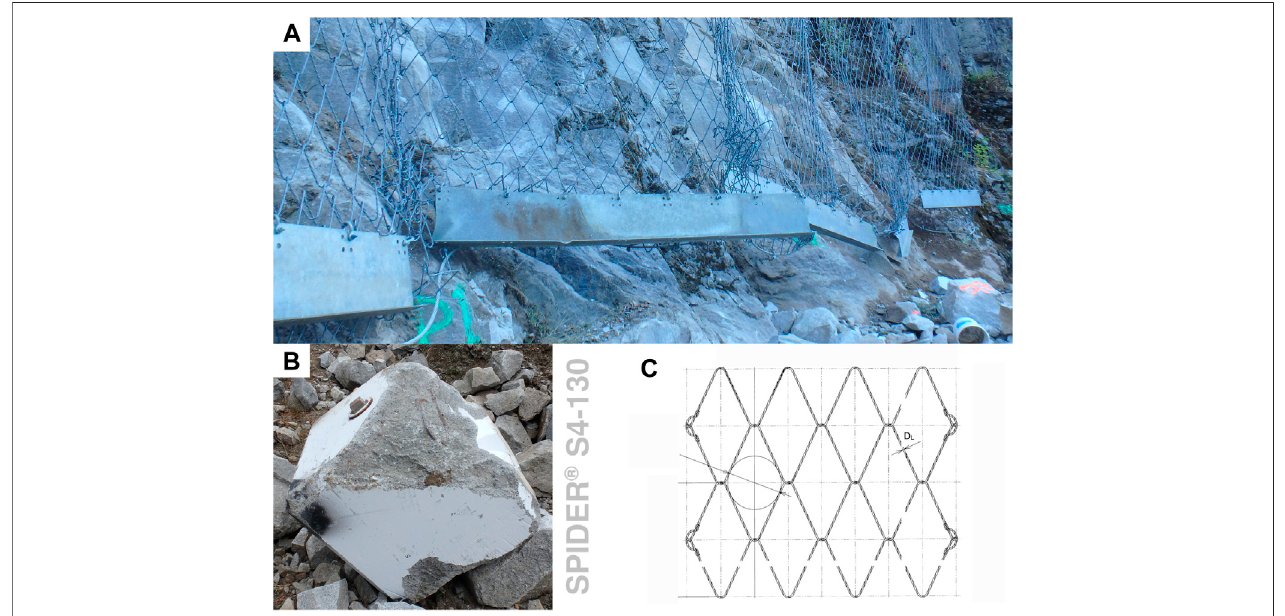
FIGURE 6 | Experiment setup. (A) Additional weight at the bottom of the protection net to ensure a more controlled structural deformation. (B) Photo of the impactingobjectT092(somedamagecanbeobserved).Thevisiblemetalcapcoversthehousingofthemotionsensors. (C) TechnicaldrawingoftheSPIDER ® S4-130, taken from Geobrugg (2020), D L (cid:1) 8 . 6 mm